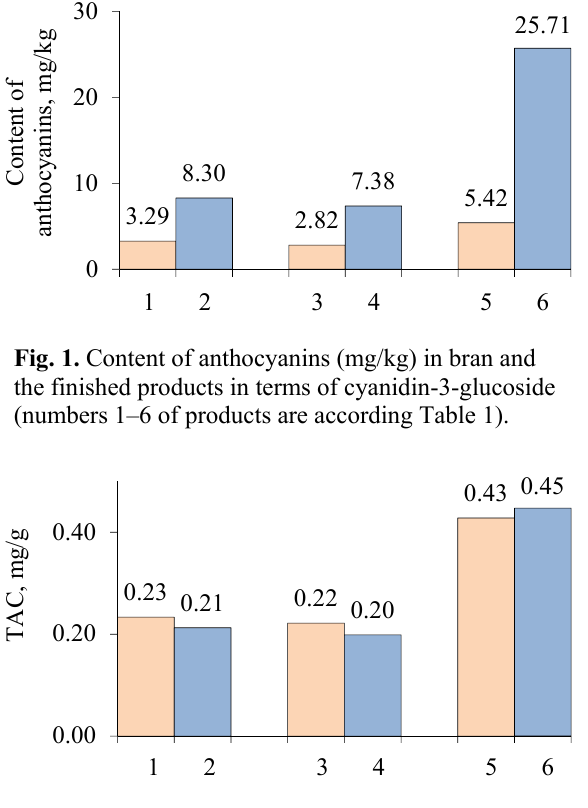
Fig. 2. Content of antioxidants (mg/g) in biscuit made with the addition of the bran of the control strain and the strain of wheat with purple grain and the content of anthocyanins in bran (numbers 1–6 of products are according Table 1). Calculated equivalent to gallic